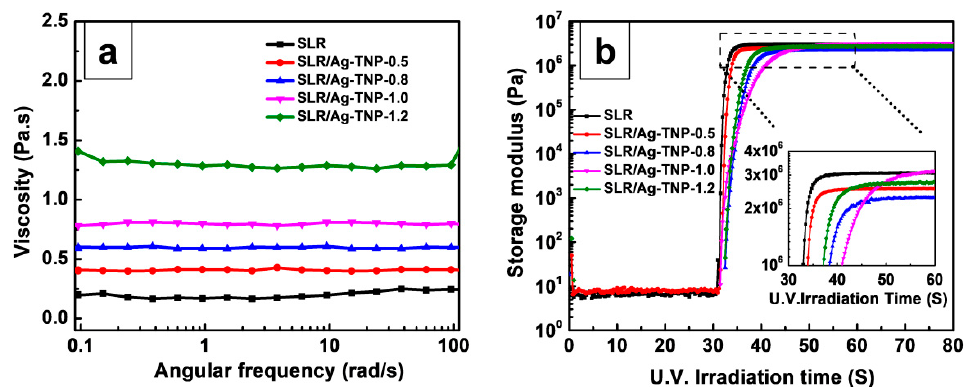
Figure 5. The DHR-2 UV LED analyses of neat SLR and SLR / Ag-TNP nanocomposites ( a ) viscosity variations of SLR / Ag-TNP and neat SLR nanocomposites as a role of shear speed at di ff erent concentrations of Ag-TNP loading, ( b ) the consequence of Ag-TNP on the dynamics of the UV light curing response. The mini insert graph in the ( b ) was an engorged sight of the curves among time = 30 to 60 s (a black dotted rectangular line marked the exact focused area).